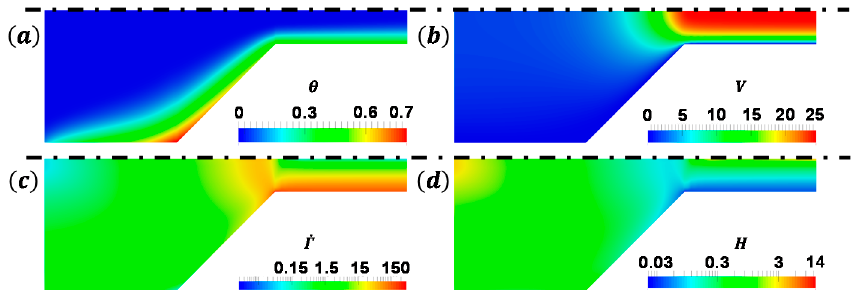
Figure 9. Contours of dimensionless ( a ) temperature, ( b ) velocity, ( c ) shear rate and ( d ) apparent viscosity for a constant dimensionless wall heat flux φ p = 1.08. The reference heat flux is calculated using reference temperature ( T 0 and T 1 ), inlet radius ( R i ), and the thermal conductivity of the gel. The dimensionless inlet temperature is 0 and Re gen = 2.3 × 10 − 2 .